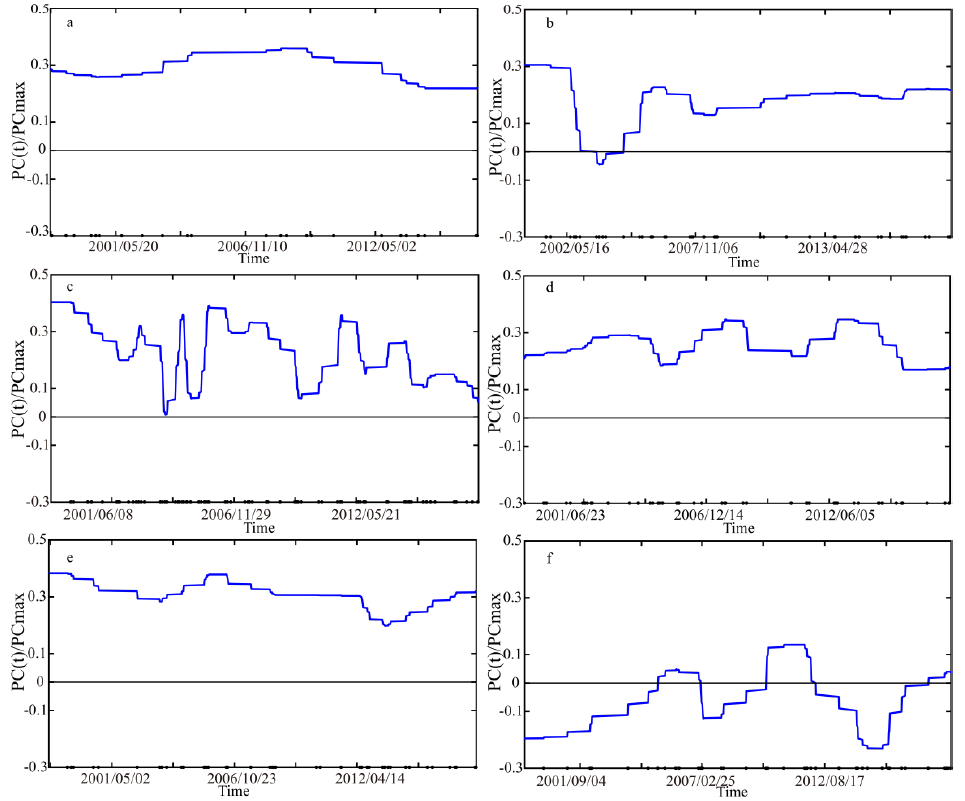
Figure 11. The first mode principal components (PCs) part results in each path period. ( a ) Northeast shift; ( b ) east turn; ( c ) middle turn; ( d ) west turn; ( e ) northwest shift; and ( f ) west